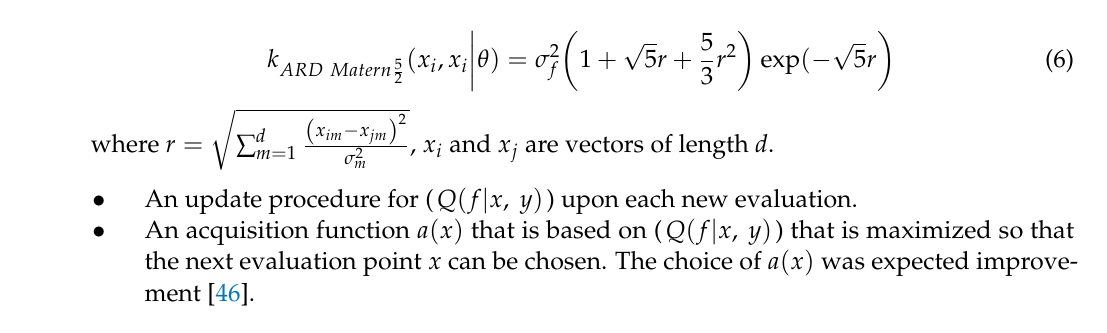
Table 2. Description of Bayesian optimization algorithm used for hyperparameter tuning (pseu- docode included in Supplementary